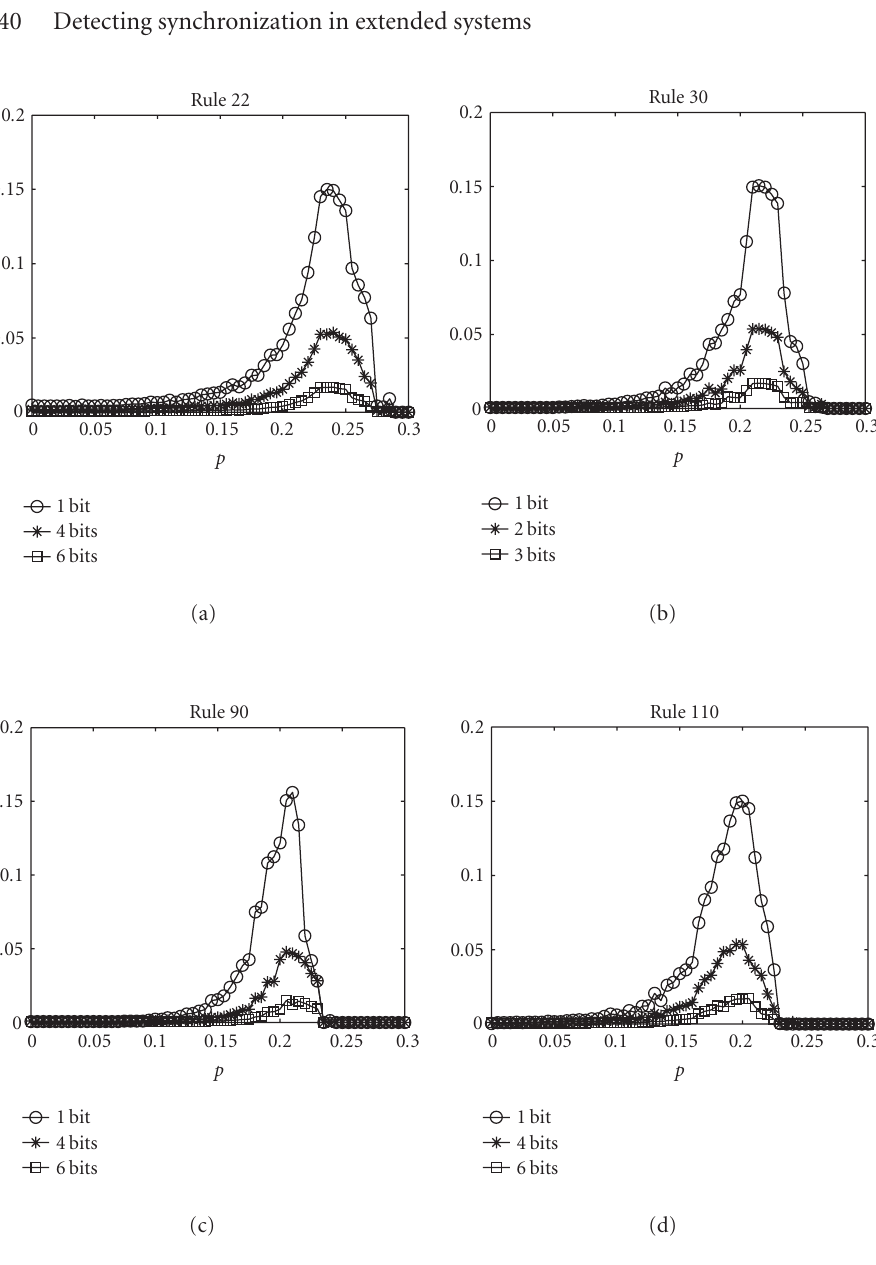
Figure 2. The normalized complexity C versus the coupling probability p for di ff erent scales of ob- servation: n o = 1 ( ◦ ), n o = 4 ( (cid:1) ), and n o = 6 ( (cid:1) ). C has been calculated over the last 300 iterations of a running of 600 of them for a lattice with L = 1000 sites. The synchronization transition is clearly depicted around p ≈ 0 . 2 for the di ff erent